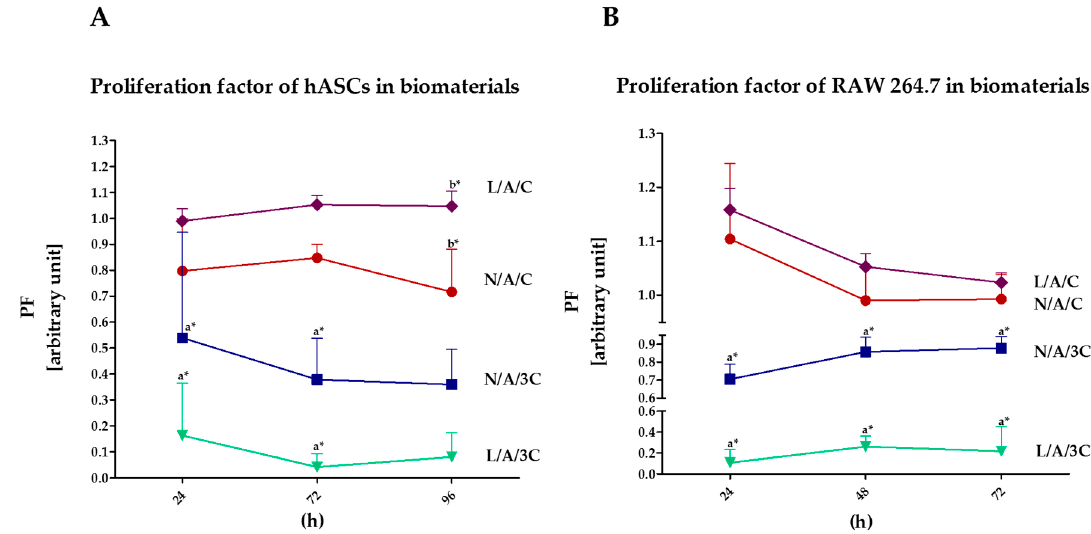
Figure 4. Proliferation activity of cells: ( A ) ASC; ( B ) RAW264.7 in biomaterials. The X -axis refers to the time of cells’ propagation. An asterisk (*) marks a statistically significant difference ( p < 0.05).